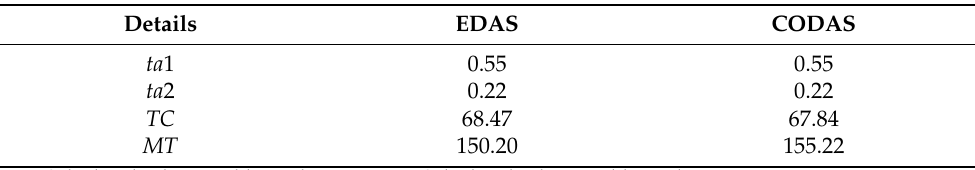
Table 13. Sub-assembly tolerance, total cost, and machining time.